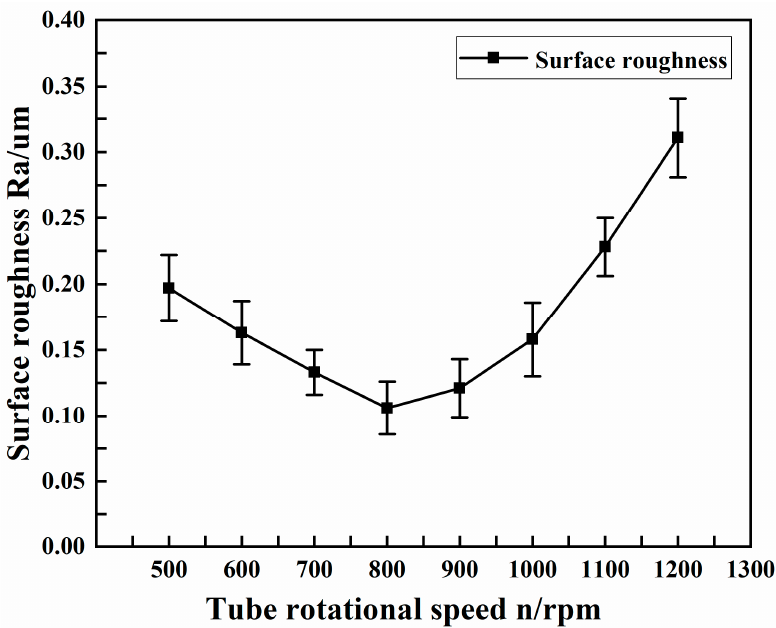
10 of 17 Table 4. Experimental conditions selected for different tube rotational speeds.